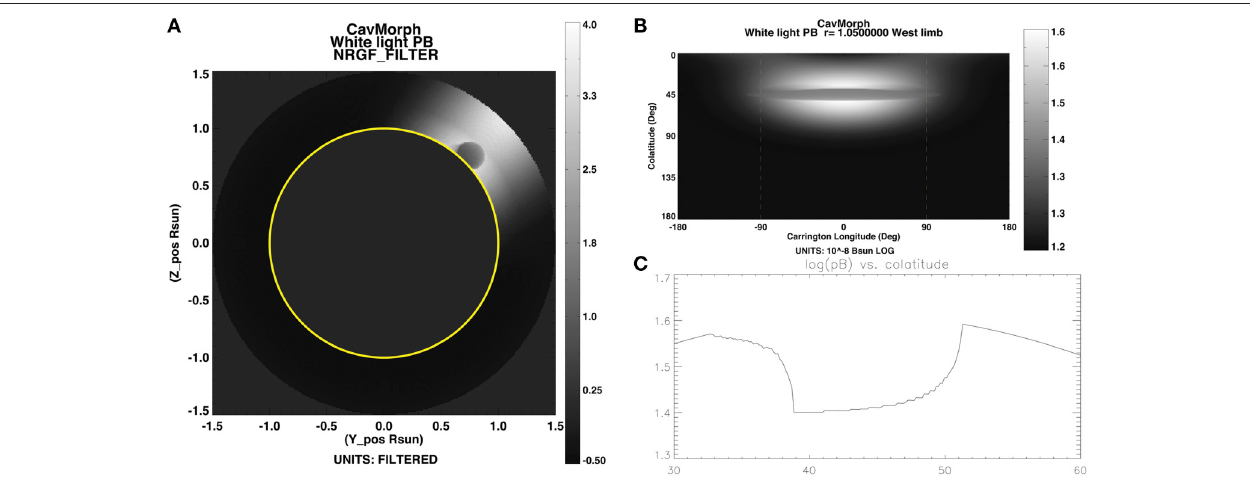
FIGURE 1 | Examples of FORWARD output of LOS-integrated white-light polarized Brightness (pB) for a morphological model of a cavity embedded in a coronal streamer (Gibson et al., 2010). (A) Cavity in plane of sky at limb (plotted with non-radial gradient filter Morgan et al., 2006). Plot obtained by FORWARD line command: for_drive,'cavmorph',inst='wl',line='pb',thcs=45,cavlength=150,rfilter='NRGF_FILTER' . (B) Cavity in latitude-longitude Carrington map. Plot obtained as for (A) , but without rfilter keyword and with ,gridtype='Carrmap',cmer=0,charsize=.85 added. (C) Cavity in constant radius latitudinal cut. Plot obtained as for (A) , but with removal of rfilter keyword and addition of keywords: ,gridtype='user',ruser=dblarr(201)+ 1.05,thuser=dindgen(201)*.15+30,phuser=dblarr(201)-30.,quantmap=quantmap and followed by command: plot,dindgen(201)*.15+30, alog10(quantmap.data),yrange=[1.3,1.7],xrange=[30.,60.],title='log(pB) vs. colatitude' . Note that this and other IDL commands provided in figure captions below can be accessed via $FORWARD_DOCS/EXAMPLES/examples_forwardpaper.html